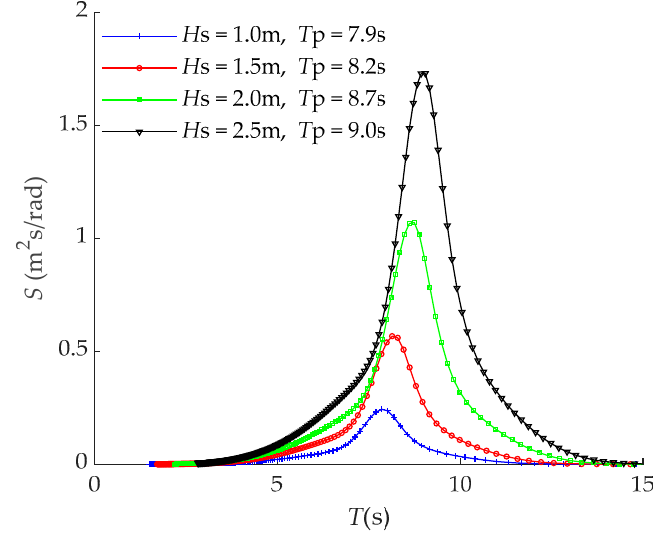
Figure 3. Jonswap spectra for four sea states.